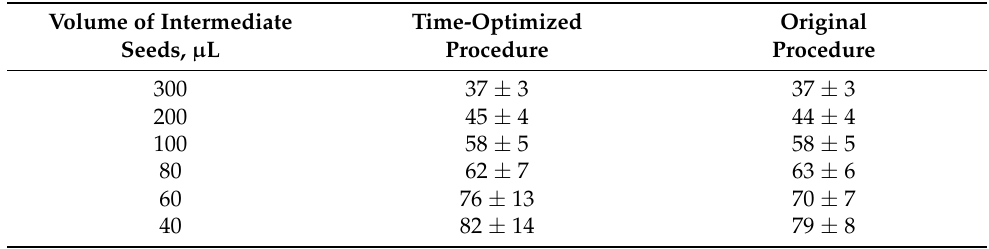
Table 3. Average edge lengths (nm ± SD) for the samples obtained after the time-optimized and original procedures.